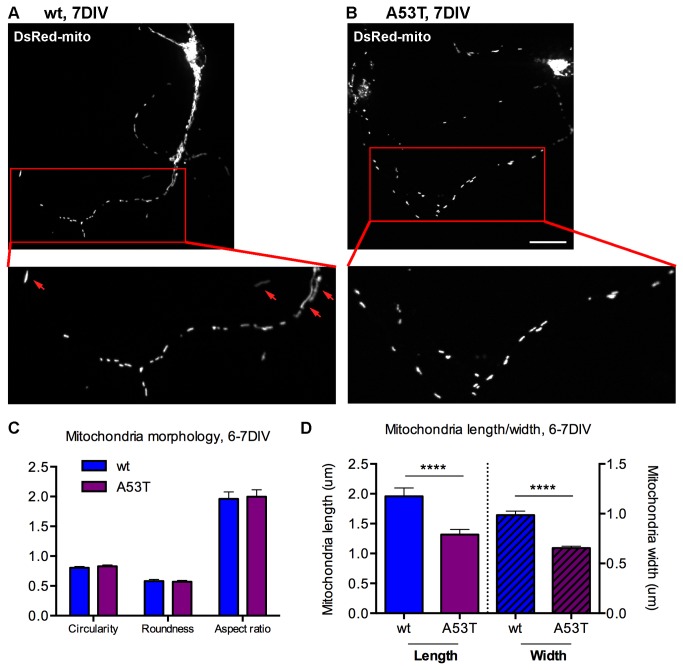
Mitochondrial shape was not substantially affected in A53T cortical neurons but the length was shortened.
A, B, Examples of mitochondrial morphology in wt (A) and A53T (B) cortical neurons at 7DIV. Cortical neurons were transfected with DsRed-mito. Higher magnification images at the bottom were from the areas highlighted by red boxes at the top images. C, Quantification of mitochondrial shape parameters (circularity, roundness and aspect ratio) in wt and A53T neurons at 6-7DIV in one representative experiment. There was no significant change in A53 neurons vs. wt neurons. D, Summary of mitochondrial length and mitochondria width in wt and A53T neurons from one representative experiment. Data plotted as Mean +/- SEM. t-test was used (****p<0.0001). Experiments were repeated 3 times (see results in Figure S3 and tables S1 & S2). Scale bar=20μm. wt=wild type, A53T=A53T α-synuclein, μm=micrometers, DIV=days in
vitro.